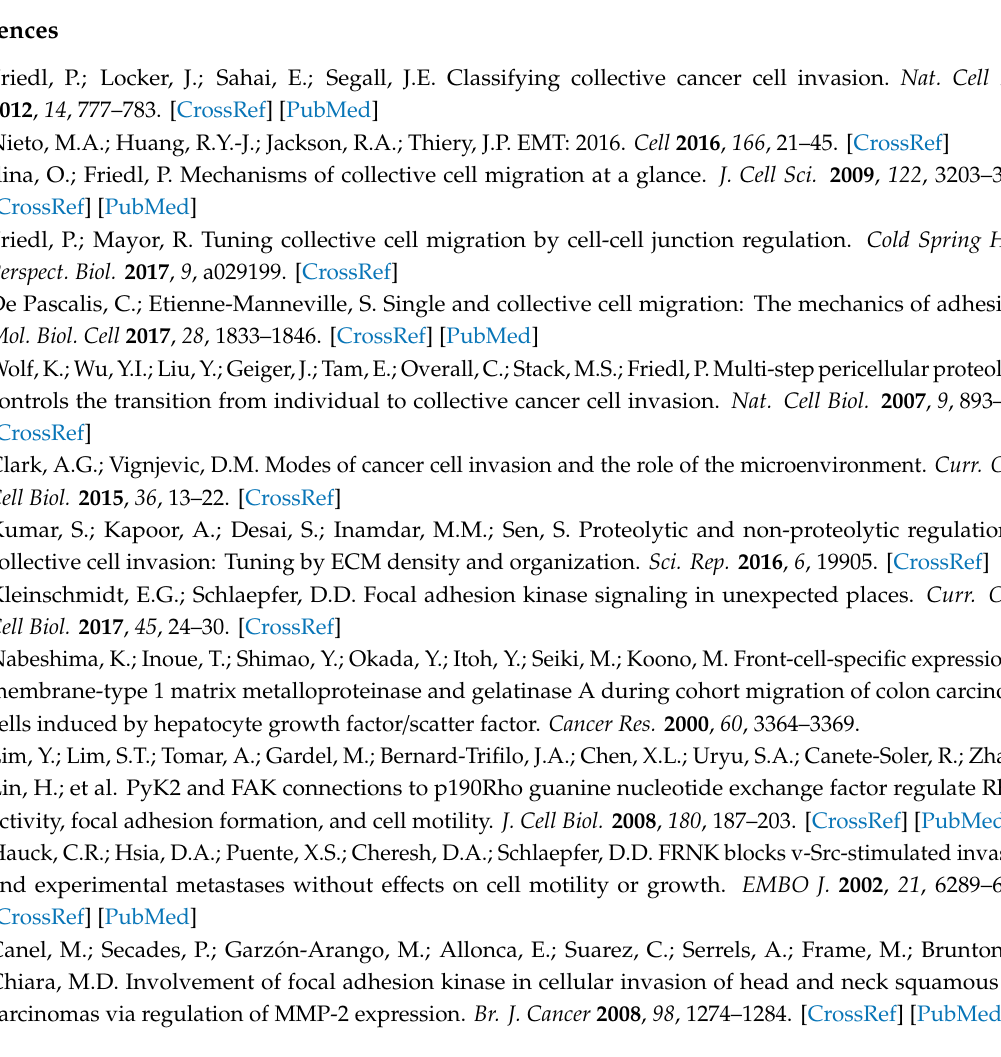
Figure S1: FRNK-induced silencing of active FAK in SCC42B cells, Figure S2: FAK and pFAK levels in SCC cell lines expressing FRNK, MMP-2, or FRNK + MMP-2 and in cells treated with siRNAs or PF-562271 inhibitor. Figure S3: FAK activity is required for e ffi cient collective cell invasion of SCC40 cells. Figure S4: Quantification of the relative amount of MMP-2 in SCC cells transfected with empty vector or with FRNK-, MMP-2, or FRNK plus MMP-2 expressing vectors. Figure S5: Three-dimensional reconstructions of Z-stacked images of spheroids. Figure S6: High levels of MMP-2 protein in the invasive fronts of head and neck SCCs. Figure S7: Clinical outcome in patients with head and neck SCCs according to the expression levels of mesenchymal genes (TCGA dataset). Figure S8: Full-length blots of Westerns showed in Figures 6–8. Table S1: Correlations of PTK2 - and MMP2 -mRNAs with expression levels of epithelial and mesenchymal genes in head and neck squamous cell carcinomas included in the TCGA database. Video S1: Representative video showing migration of a cell spheroid assembled with SCC42B cells and recorded for 5 h. Video S2: Representative video showing migration of a cell spheroid assembled with F-SCC42B cells and recorded for 5 h. Video S3: Representative video showing migration of a cell spheroid assembled with FM-SCC42B cells and recorded for 5